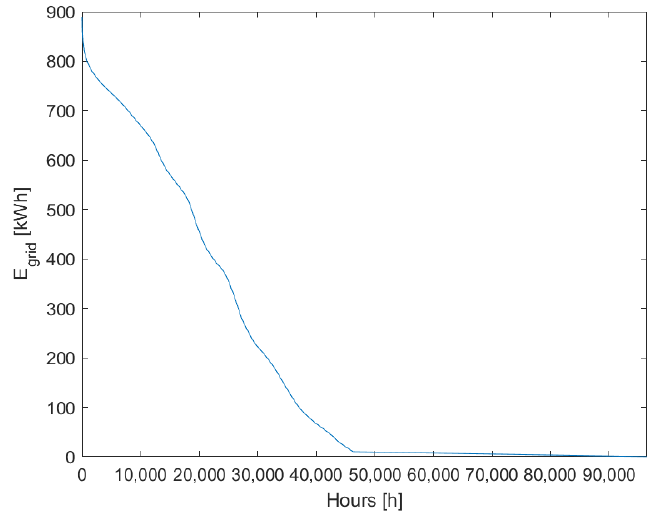
Figure 1. Generation duration curve without storage.